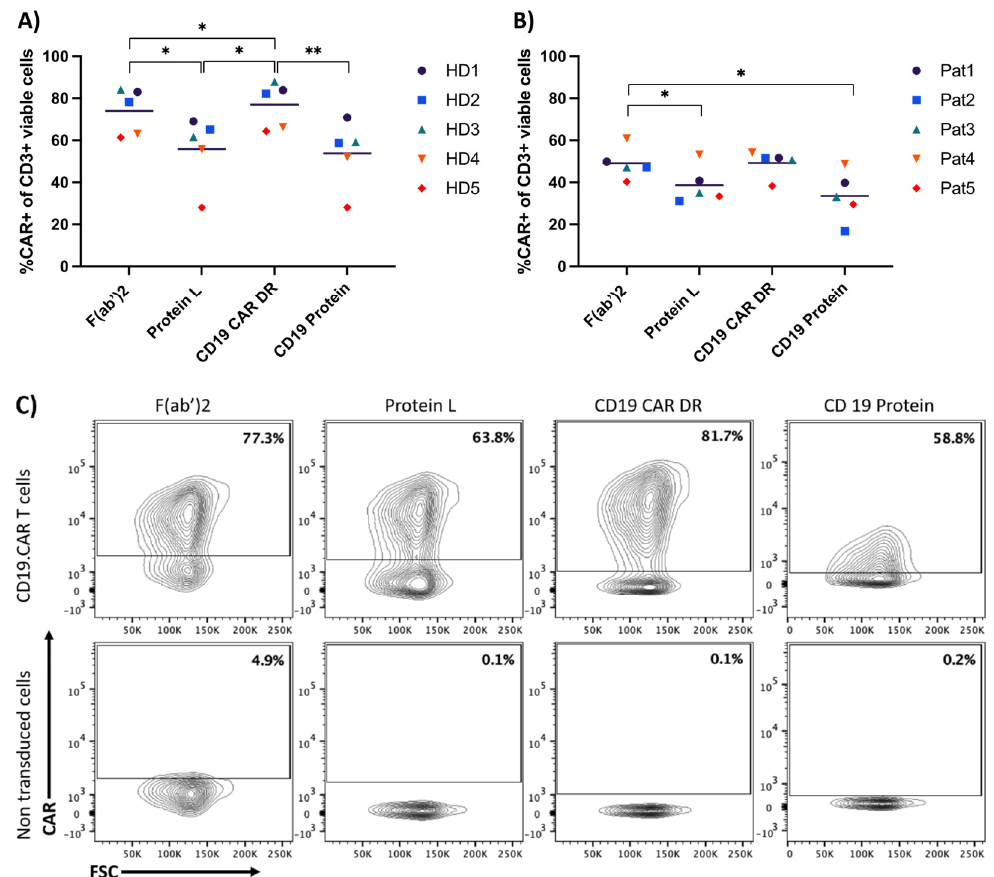
Figure 2. Comparison of four different antibodies to detect CD19-specific CAR-T cells. Both graphs show the different percentages for CAR-T cell detection when using the displayed staining reagents. ( A ) depicts the percentage of CAR-T cells produced from five different HD samples. ( B ) shows the percentage of CAR-T cells produced from five different patient samples (Pat). ( C ) shows the contour plots for CAR-T cells of one HD stained with all four different antibodies. The gate for the non-transduced cells is the same as in the respective CD19.CAR-T cell group. Comparison for HDs and patient samples were evaluated in three independent experiments respectively. (*) p < 0.05; (**) p < 0.01 by one-way ANOVA.